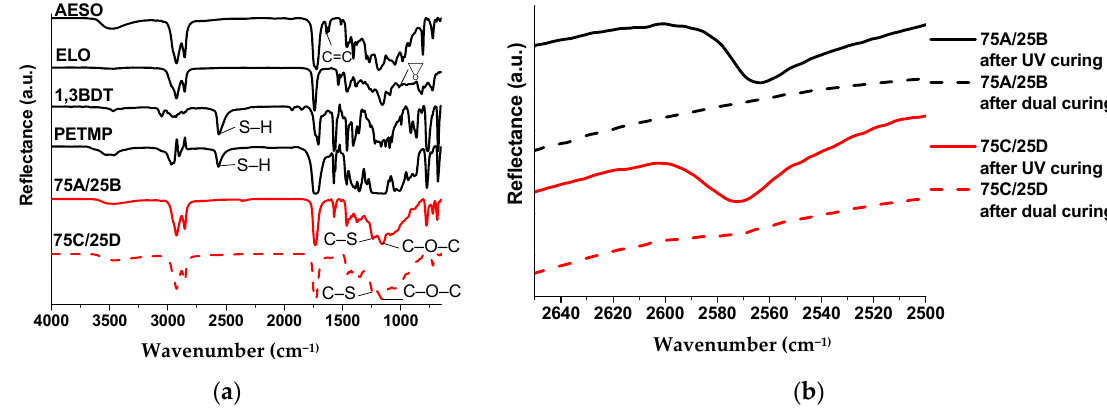
Figure 4. ( a ) FT-IR spectra of AESO, ELO, 1,3BDT, PETMP, cross-linked polymers 75A/25B and 75C/25D; ( b ) FT-IR region corresponding to S–H group absorption signal of the resins 75A/25B and 75C/25D after UV irradiation and after complete curing.